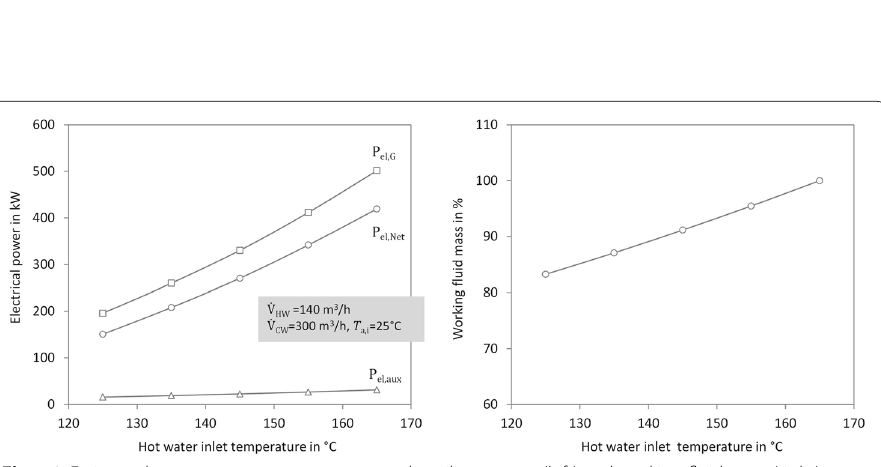
Fig. 16 Estimated generator power, net power and auxiliary power (left) and working fluid mass (right) depending on the hot water